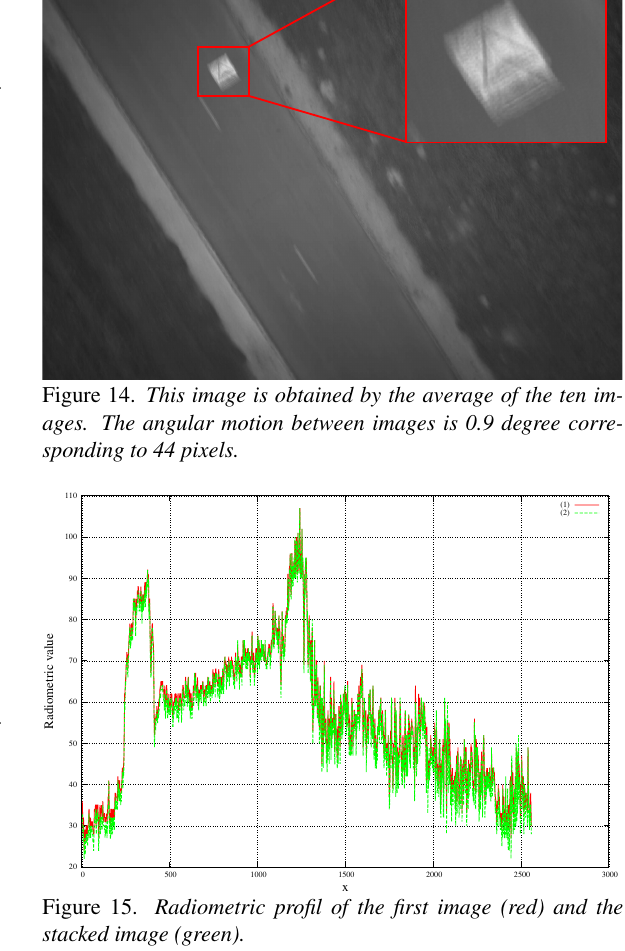
Figure 16 and Figure 17 illustrate a case where the UAV has suffered a X-translation movement. Here, the rotation estimated